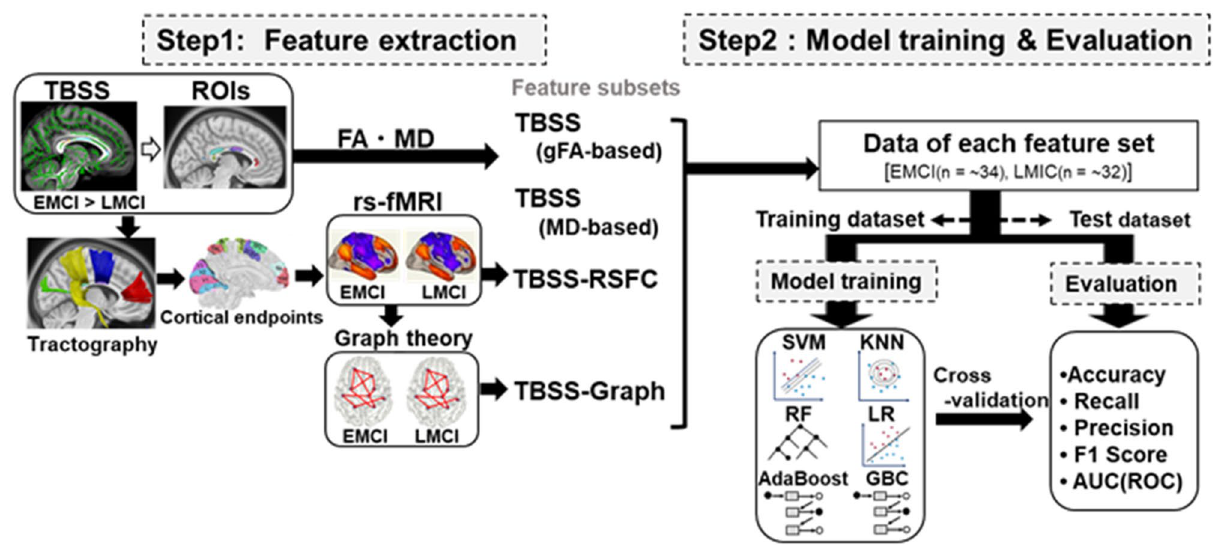
Figure 1. Flow chart representing Machine learning (ML) approach for EMCI/LMCI classification. The flow chart represents the framework of machine learning (ML) algorithm for EMCI/LMCI classification. Step1 consists of feature extraction by multi-modal methods, including TBSS, tractography, RSFC, and graph theory. Step 2 consists of ML models (SVM, KNN, LR, DTC, RF, GBC, AdaBoost) with tenfold cross-validation (CV). The dataset was divided into training and test dataset for tenfold CV, calculating the mean ‘accuracy (ACC)’, ‘recall’, ‘precision’, ‘F1 score’, and ‘AUC(ROC)’. MCI mild cognitive impairment, EMCI early MCI, LMCI late MCI, FA fractional anisotropy, MD mean diffusivity, TBSS Tract-based spatial statistics, RSFC resting-state functional connectivity, CV cross-validation, ROI range of interest, ML Machine learning, KNN k-nearest neighbor algorithm, LR Logistic Regression, DTC Decision Tree Classification, RF Random Forest, SVM support vector machine, GBC gradient boosting classifier, AdaBoost Adaptive Boosting, ACC accuracy, ROC Receiver operating characteristic, AUC Area under the